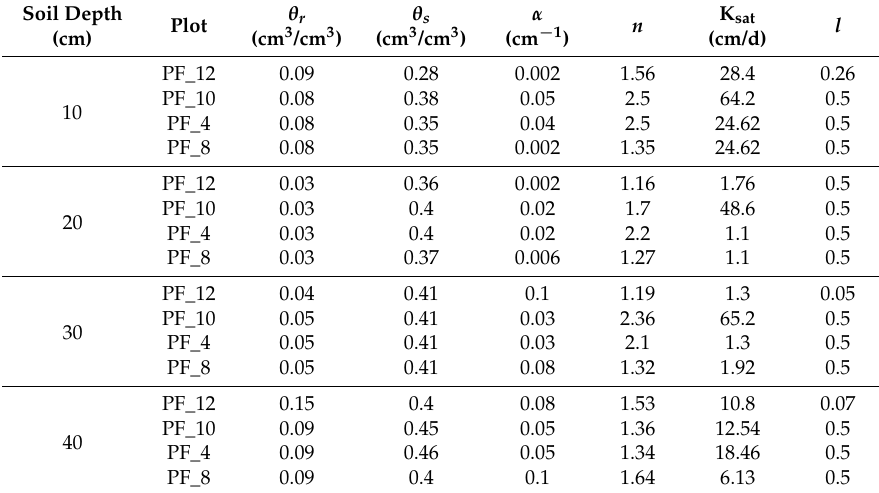
Table 7. Calibrated van Genuchten hydraulic parameters from the different plots at the fringe zone of the